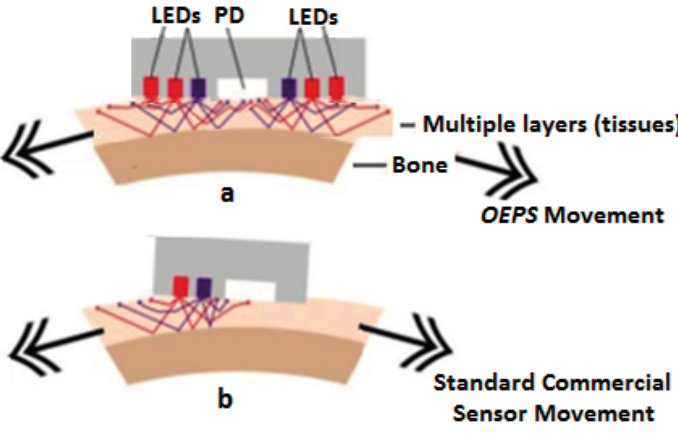
Figure 8. Sensor displacement altering backscattered